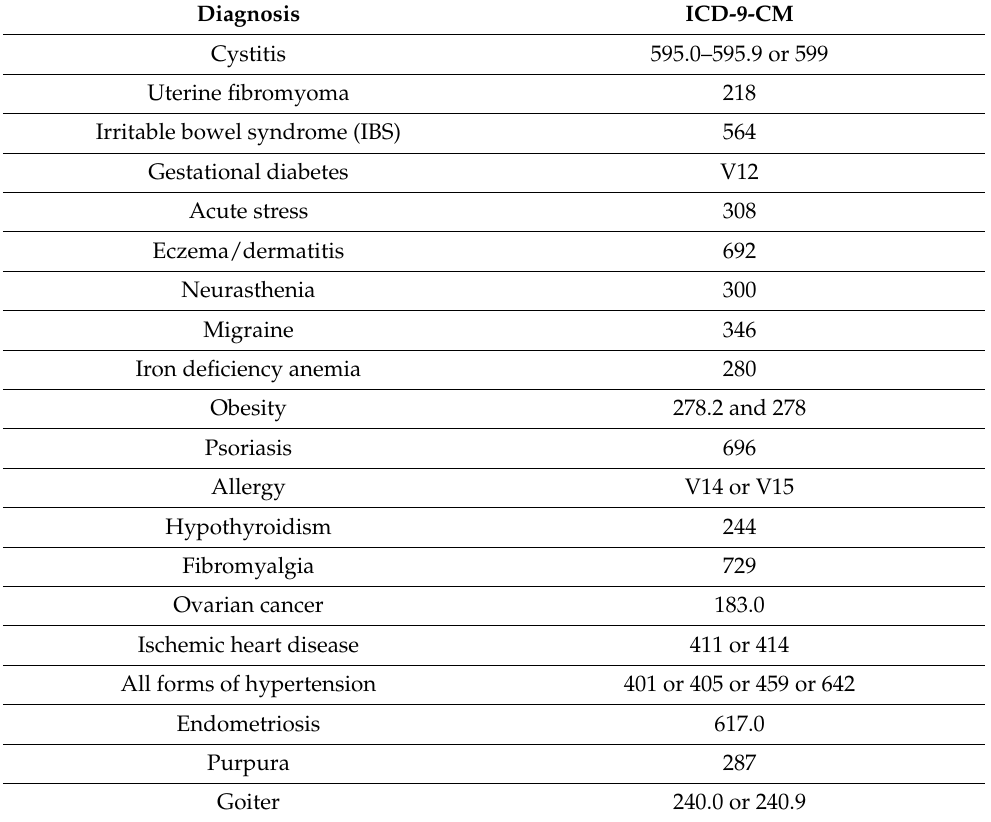
Table A1. ICD-9-CM codes for diagnoses mentioned in the